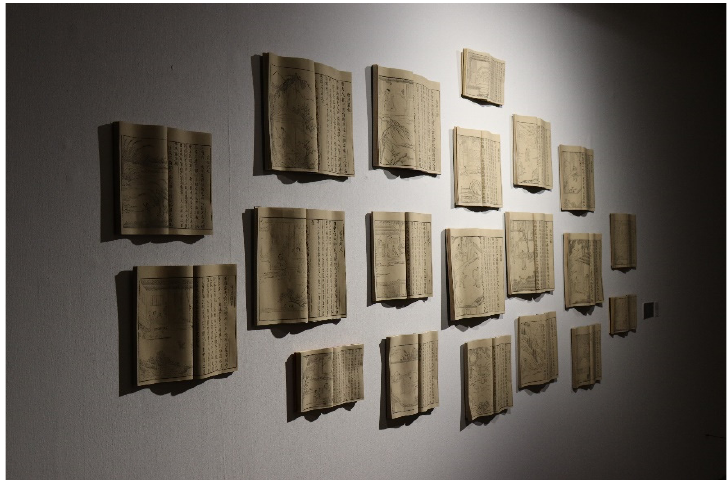
Figure 5. “Handbook for the Boudoir” by Wei Peng, variable size, digital printing, installation, 2019. Picture from the Center for Visual Studies, Peking University.